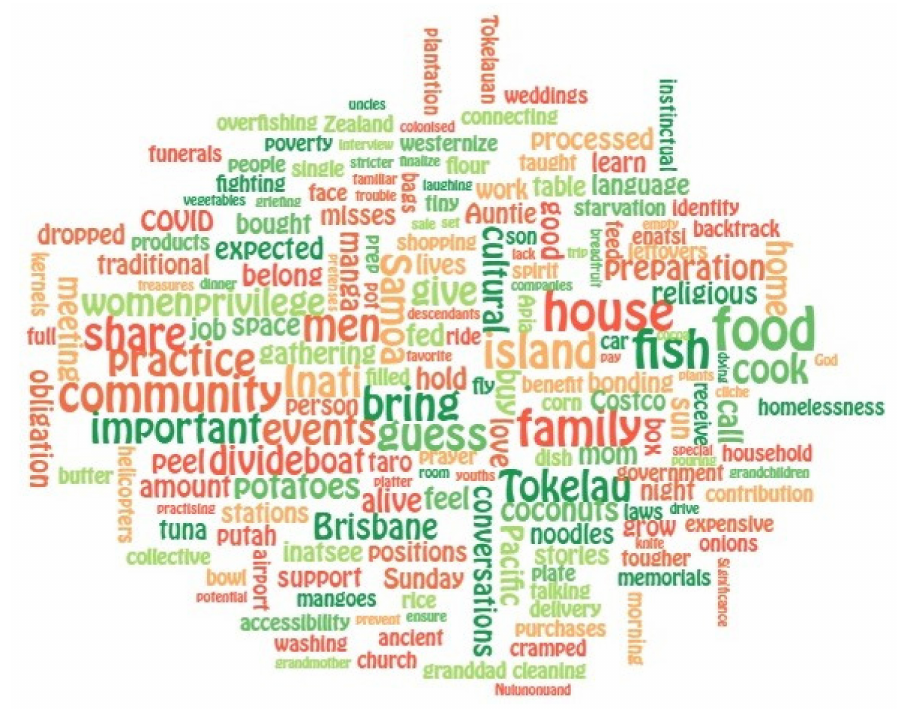
Figure 2. Wordle example from one of the